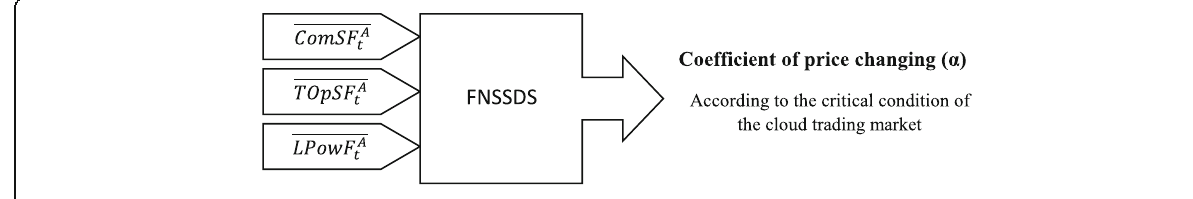
Fig. 4 An abstract view of the FNSSDS